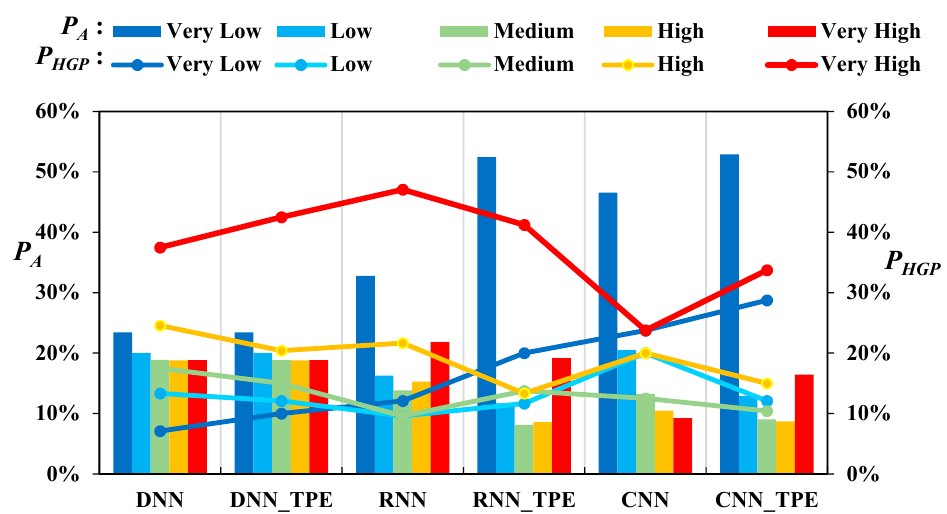
Figure 12. The statistics of each class of LSMs constructed by the models (PA is the proportion of each susceptibility class; PHGP is the proportion of historical landslide points in each class in each LSM).